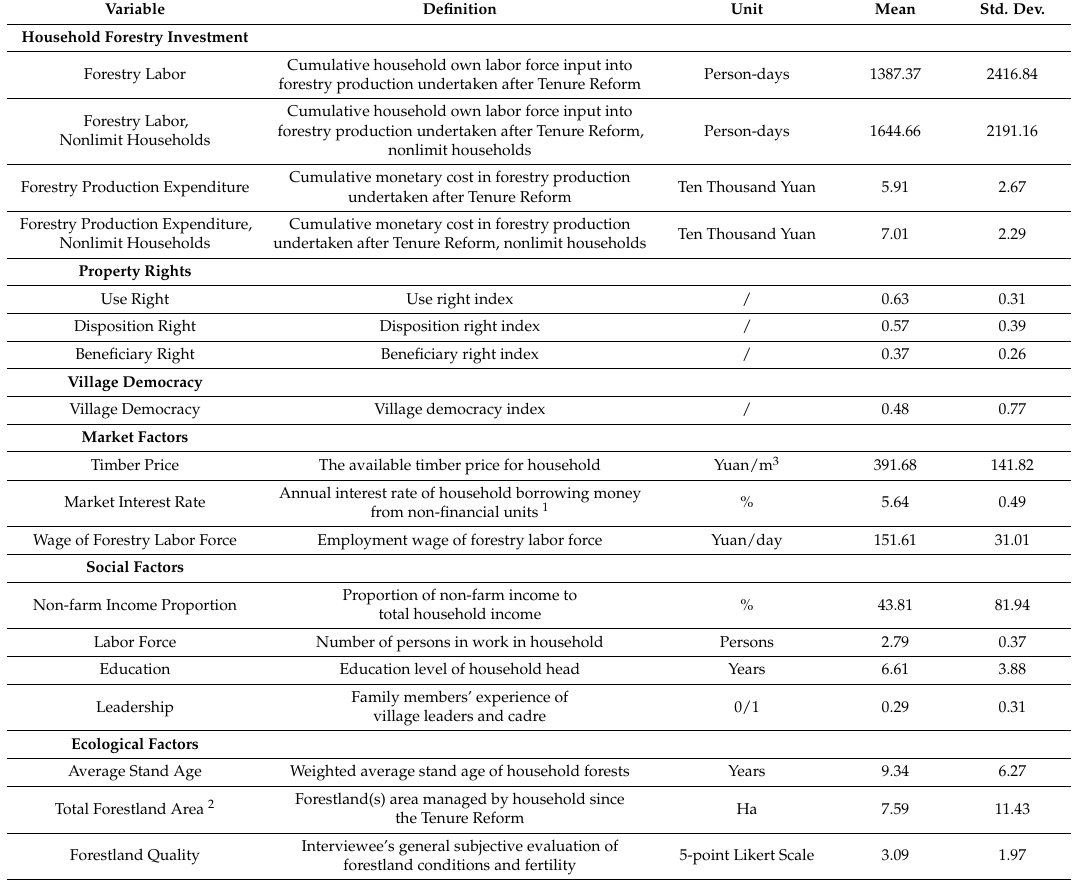
Table 1. Descriptive statistics of the data. (whole sample, N =